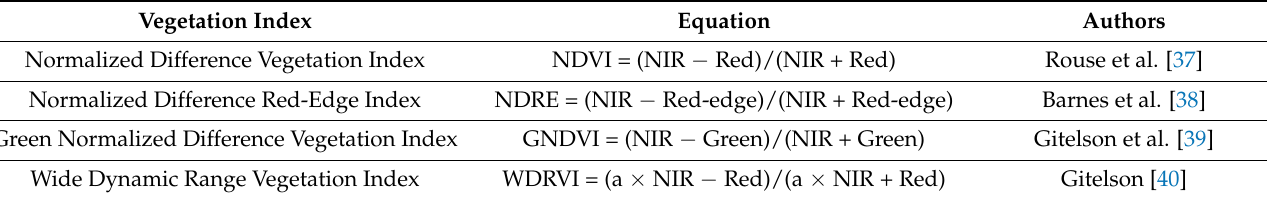
Table 2. Vegetation index considered in this study.